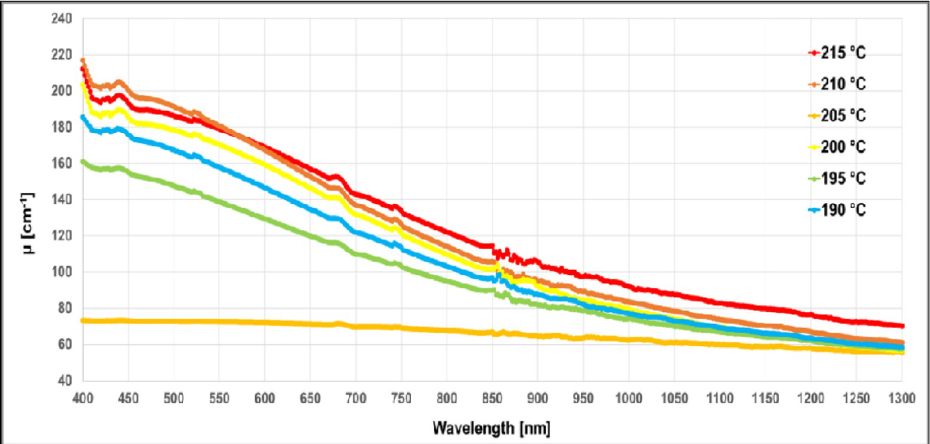
Fig 5. Extinction coefficient μ spectra in the wavelength range 400–1300 nm for the white PLA filament from MDKOEM, printed at different extruder’s temperatures.